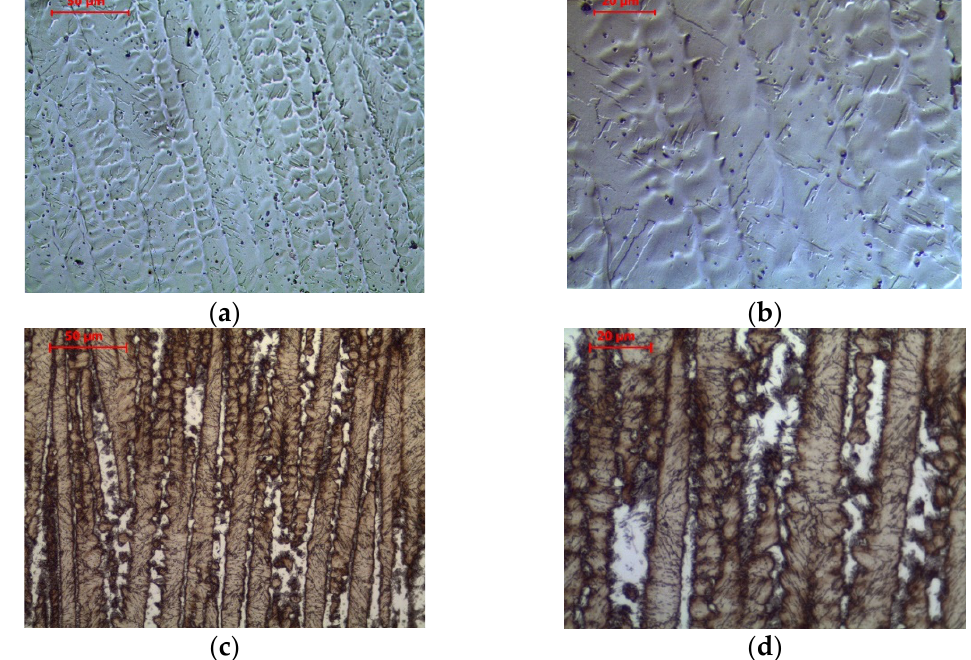
Figure 3. Microstructure of wire arc additive manufactured 18Ni-12Co-4Mo-Ti maraging steel in the: ( a , b ) 10th layer, ( c , d ) 6th layer. 4% Nital etched.